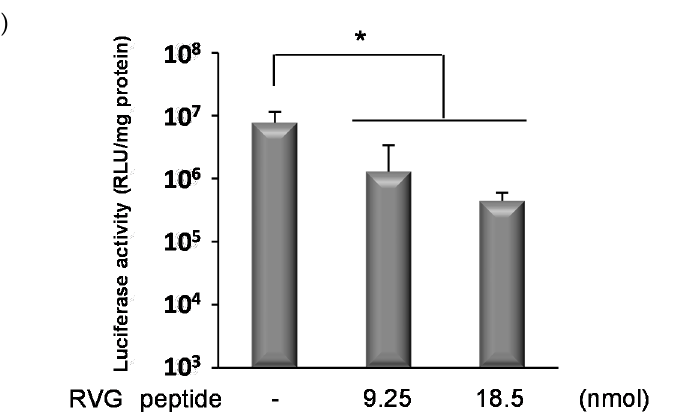
Figure 3. Specific interaction with ternary complexes and Neuro2a cells. ( a ) Neuro2a cells and ( b ) HeLa cells were incubated with ternary complexes containing YOYO-1 (green) labeled pDNA (0.4 µ g/well) for 2 h. Cells were fixed, stained with DAPI (blue), and evaluated by fluorescence microscopy. Scale bars represent 10 µ m. ( c ) The influence of preincubation with RVG peptide for 1 h on the transfection by ternary complexes (pDNA 1 µ g/well, N/P 10, PEG-PEI:RVG-R9 = 8:2). The bars show the mean and S.D. ( n = 3). * indicates p < 0.05 using a one-way ANOVA with Tukey’s post-hoc test.